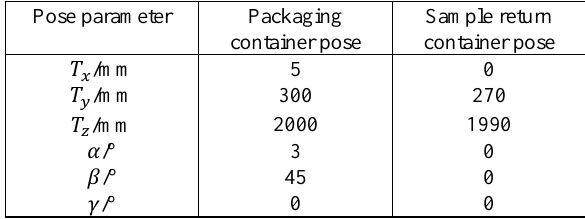
Table 1. Pose parameters used in the simulation